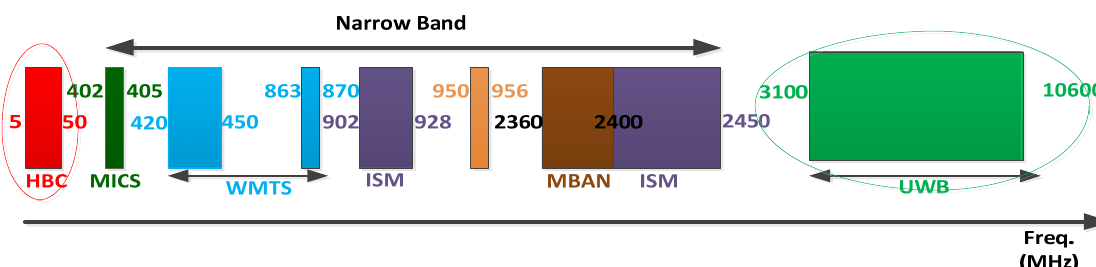
Figure 6. Radio Frequency Spectrum for WBAN Communications [9].